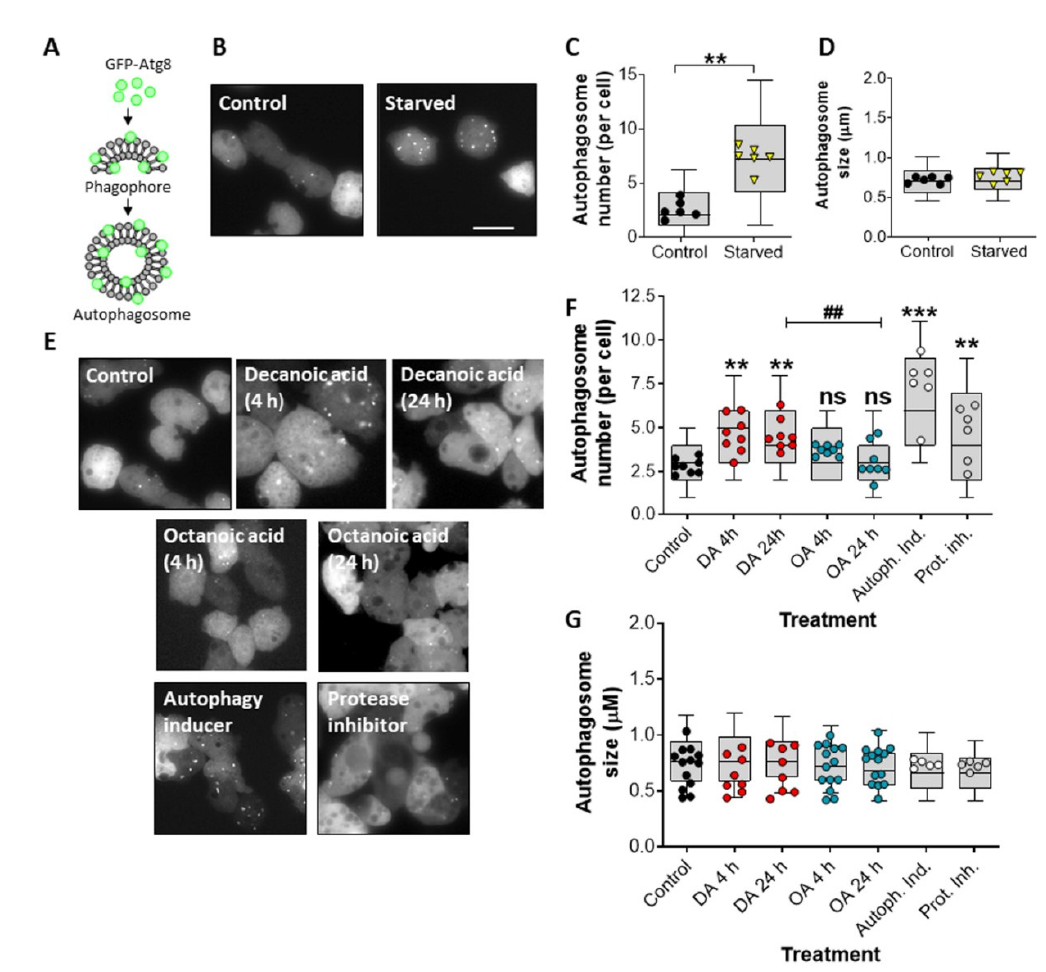
Figure 1. Decanoic acid induces autophagosome formation in Dictyostelium . ( A ) Exogenous GFP-Atg8 is integrated into the membranes of the phagophore and autophagosome to allow visualization of autophagy in cells. ( B ) Representative images of Dictyostelium cells expressing GFP-Atg8, untreated (control) or starved (1 h), and following analysis for ( C ) autophagosome number and ( D ) autophagosome size, shown as mean ± SEM ( n = 6, Mann–Whitney t -test). ( E ) Representative images of Dictyostelium cells expressing GFP-Atg8 untreated (control, DMSO) or treated with decanoic acid (DA, 60 µ M) or octanoic acid (OA, 60 µ M) for 4 or 24 h, autophagy inducer (AR-12, 2.5 µ M), or protease inhibitor (2.5 × ). Images were analyzed for ( F ) autophagosome number and ( G ) autophagosome size ( n ≥ 6), shown as mean ± SEM (Kruskal–Wallis with Dunn’s multiple comparisons test). Significance against control is indicated by ns p > 0.05, ** p ≤ 0.01, *** p ≤ 0.001, or between decanoic acid and octanoic acid, ## p ≤ 0.01. Scale bars represent 20 µ m. Each data point is derived from at least 30 individual cells or autophagosomes, with box and whisker plots showing 10–90th percentile range.